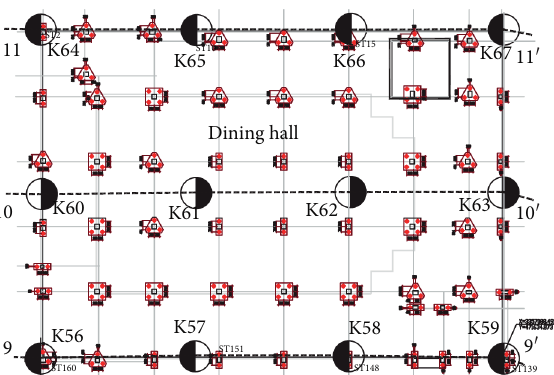
Figure 3: The investigation site with pile location layout of dining